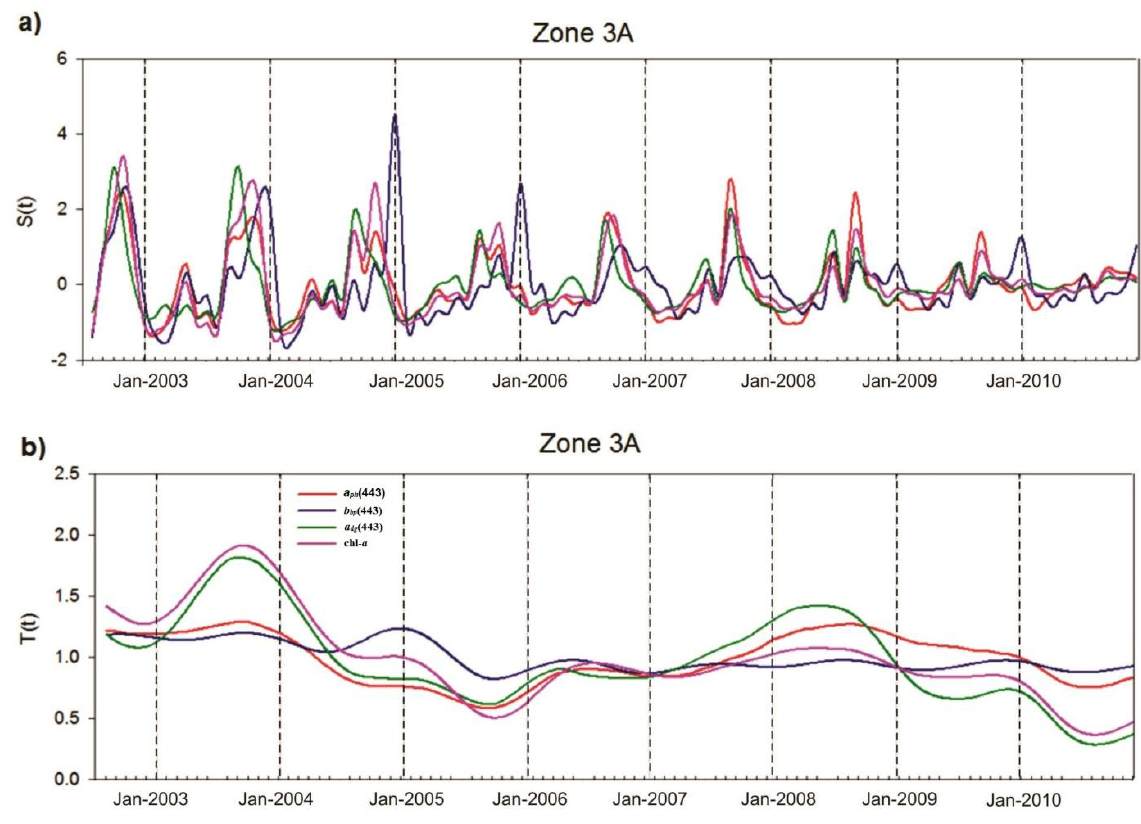
Figure 10. X-11 terms statistics of a ph (443) , b bp (443) , a dg (443) and chl- a in the zone of interest 3A. ( a ) S(t) (seasonal term); ( b ) T(t) trend